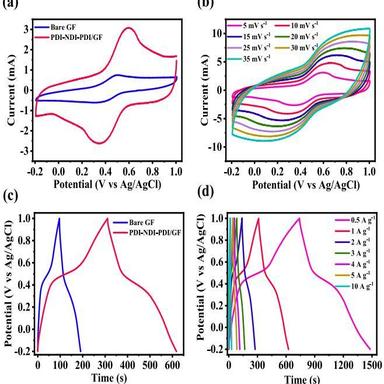
(a) Comparative CVs bare GF, PDI-NDI-PDI/GF at scan rate of 5 mV s − 1 ; (b) CVs of the device at various scan rates of 5, 10, 15, 20, 25, 30 and 35 mV s − 1 ; (c) GCD profiles of bare GF, PDI-NDI-PDI/GF at a current density of 1 A g− 1 ; (d) GCD of PDI-NDI-PDI/GF-based PSC device at various current densities (0.5, 1, 2, 3, 4, 5, and 10 A g− 1 ).